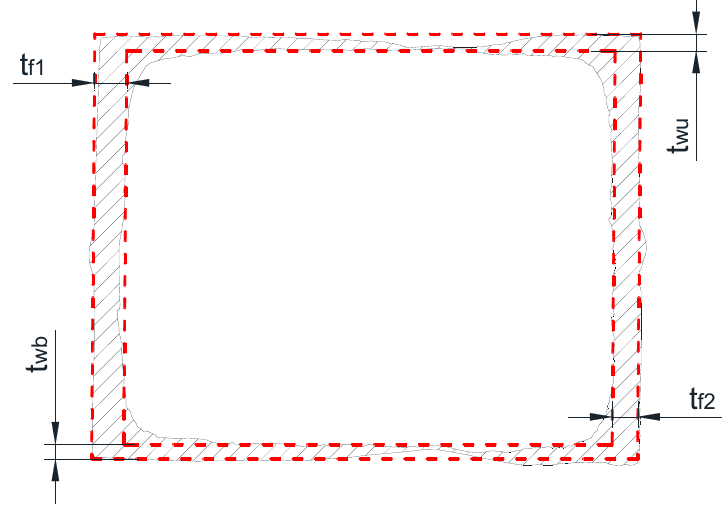
Figure 8. Illustration of the simplified cross-sectional geometry. Table 2. Geometric characteristics of the simplified geometry.